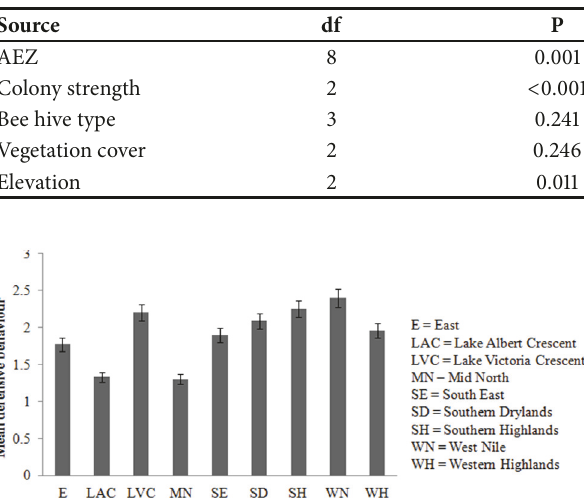
Table 1: Effects of environmental and colony factors on honeybee colony defensive behaviour.